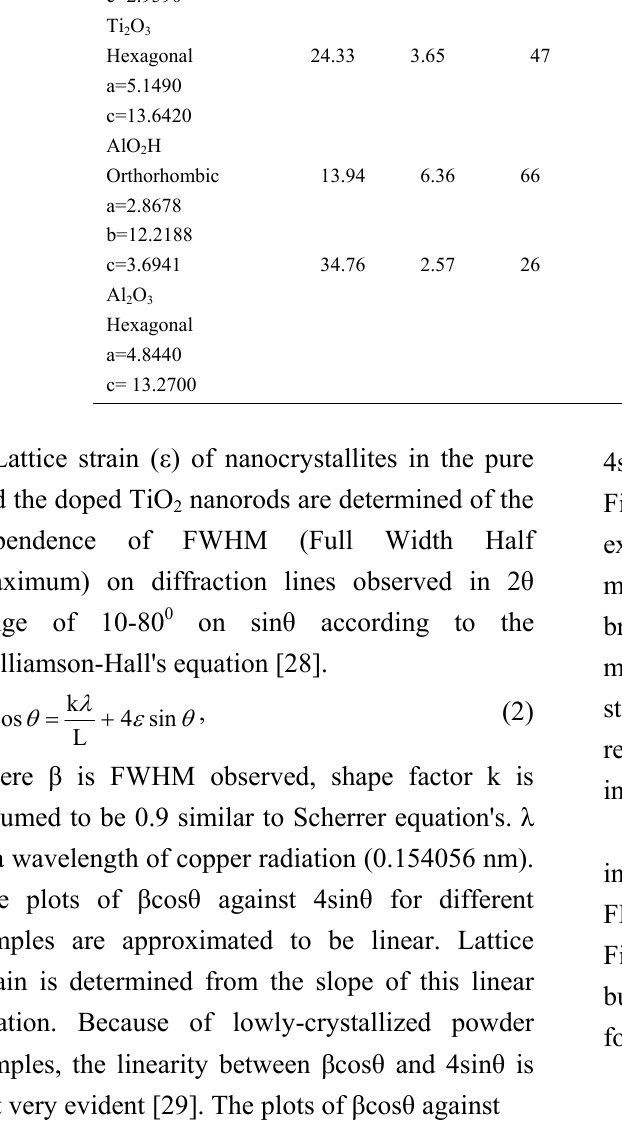
Table 3. The 2 θ angle, d-space, Miller indexes, grain size of pure TiO